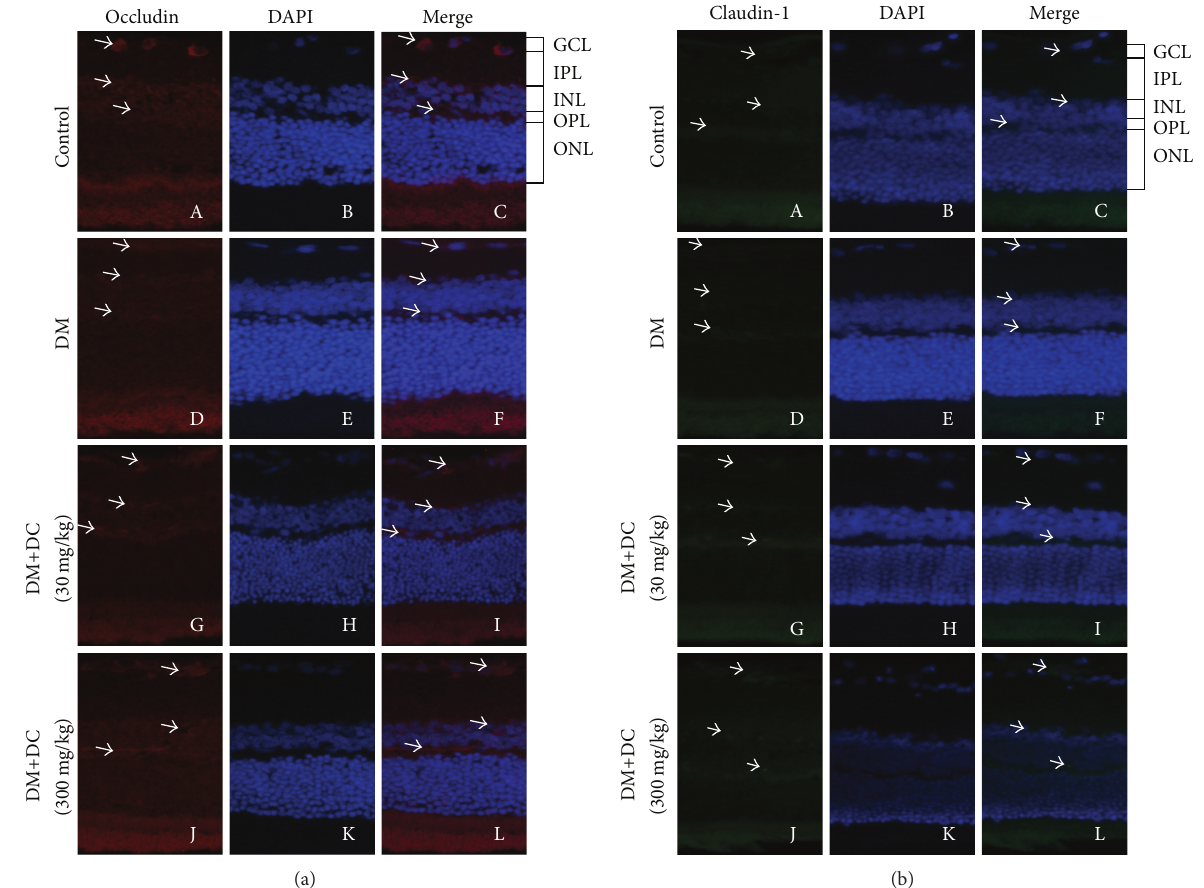
Figure 3: The expression of occludin and claudin-1 in retinas. (a) The representative pictures of retinal immunofluorescence staining of occludin (A, D, G, and J) and DAPI (B, E, H, and K). Merge of occludin- and DAPI-stained images (C, F, I, and L). (b) The representative picturesofretinalimmunofluorescencestainingofclaudin-1(A,D,G,andJ)andDAPI(B,E,H,andK).Mergeofclaudin-1-andDAPI-stained images (C, F, I, and L) (original magnification ×